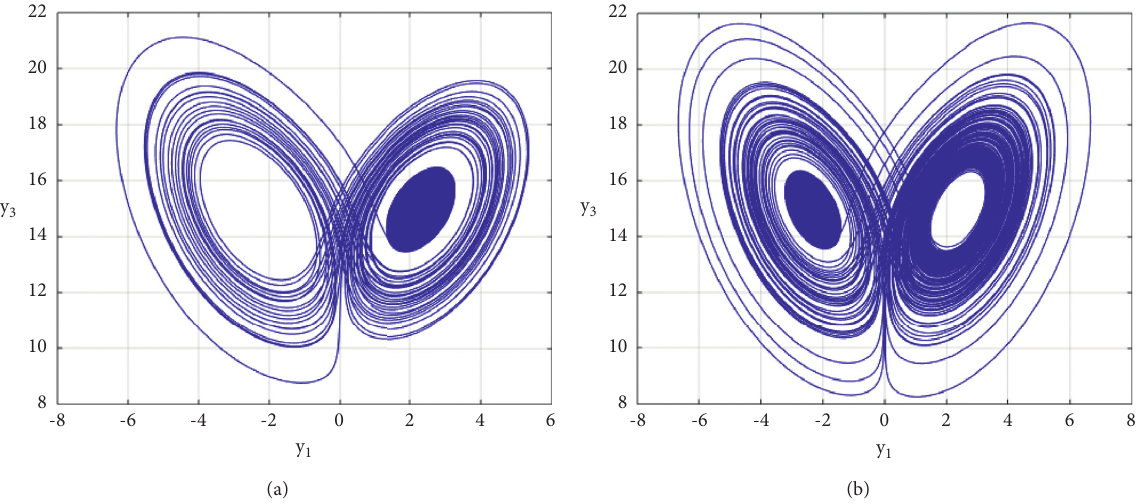
Figure 8: The one-eyed face self-excited chaotic attractor of the fractional-order Matouk’s system in the y ( 0 . 01 , 0 . 01 , 0 . 01 , 0 . 01 ) , a � − 3 , b � 15 , d � − 0 . 0001 ,h � − 1 . 5 , α � 0 . 77, and (a) c � 0 . 34 and (b) c � 0 .